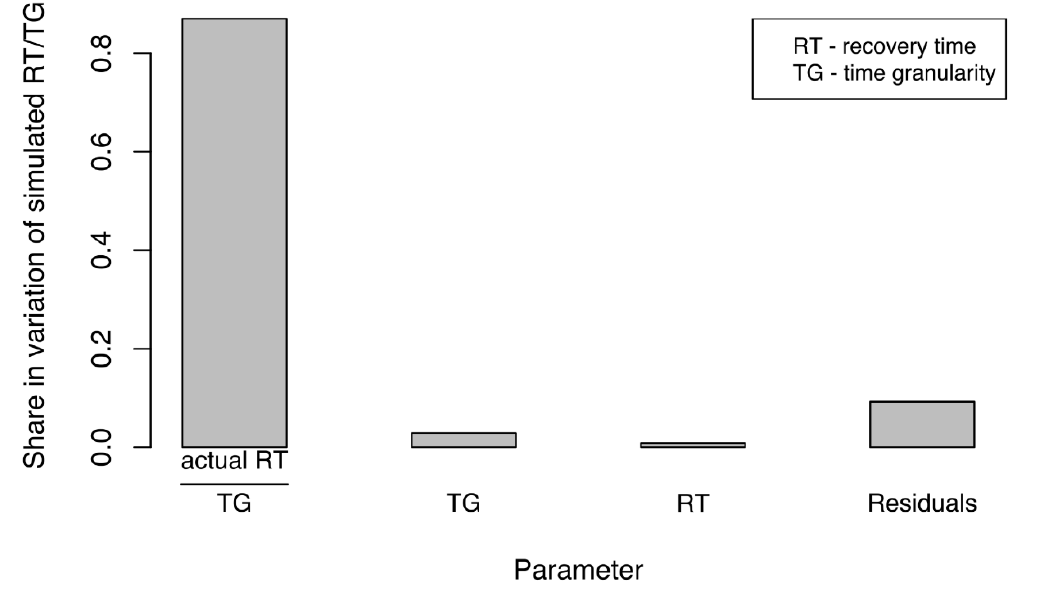
Figure 10. Variations in ratios of simulated recovery time by business network (SPRT) to time granularity due to experimental factors.